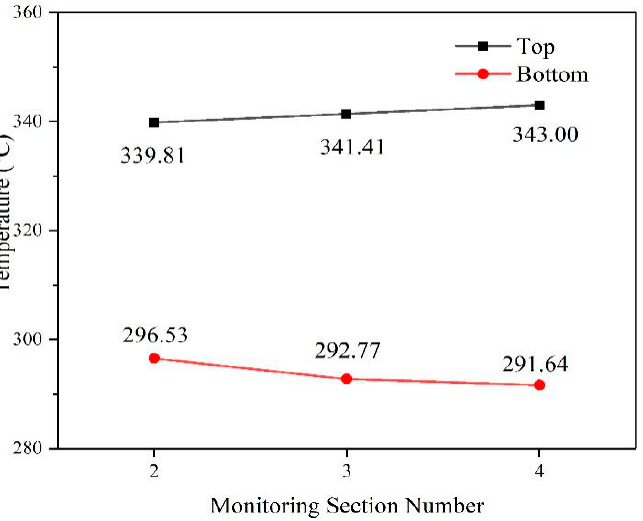
Figure 21. Comparison of the temperature at the top and bottom monitoring points in different monitoring sections.